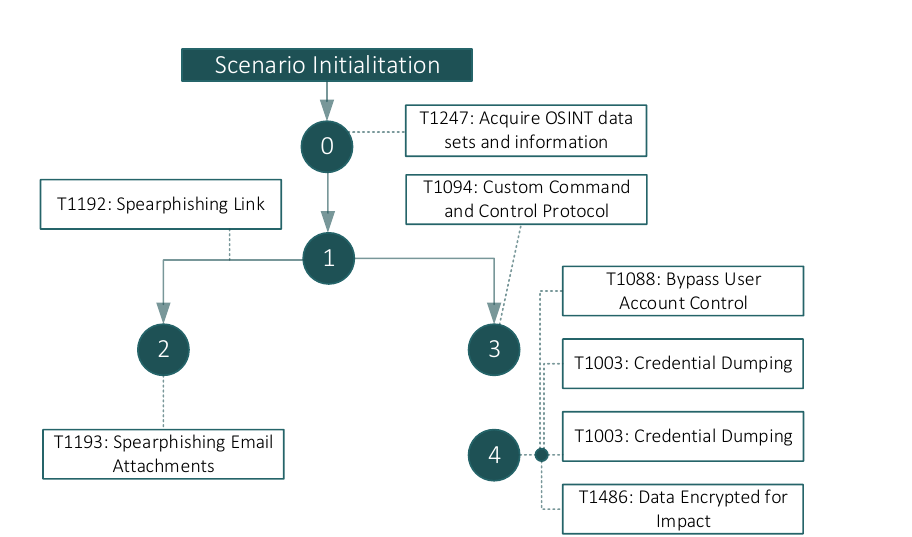
Figure 7. Scenario 3—Cyber kill chain for Credential